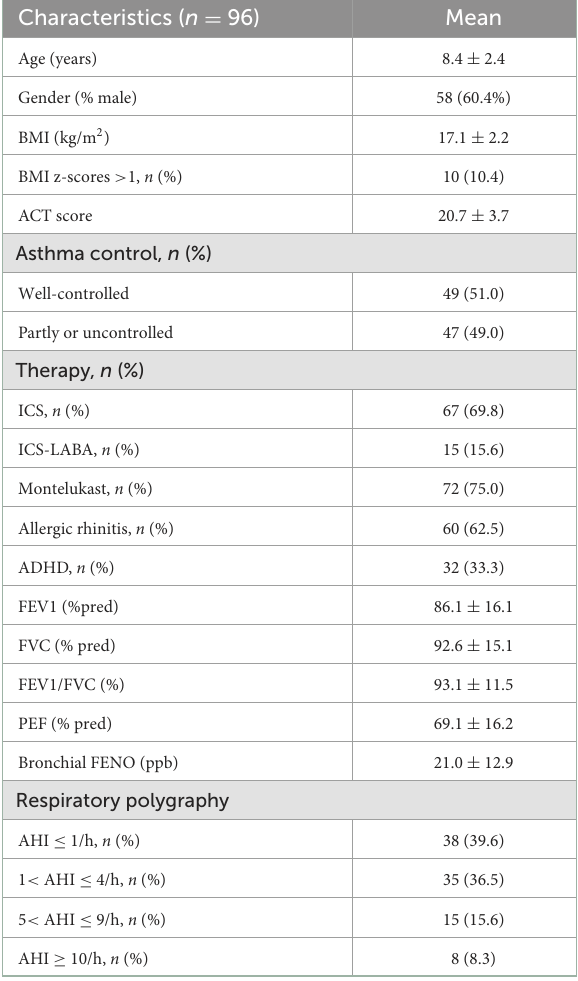
TABLE 1 Clinical and functional characteristics of study subjects. Characteristics ( n =